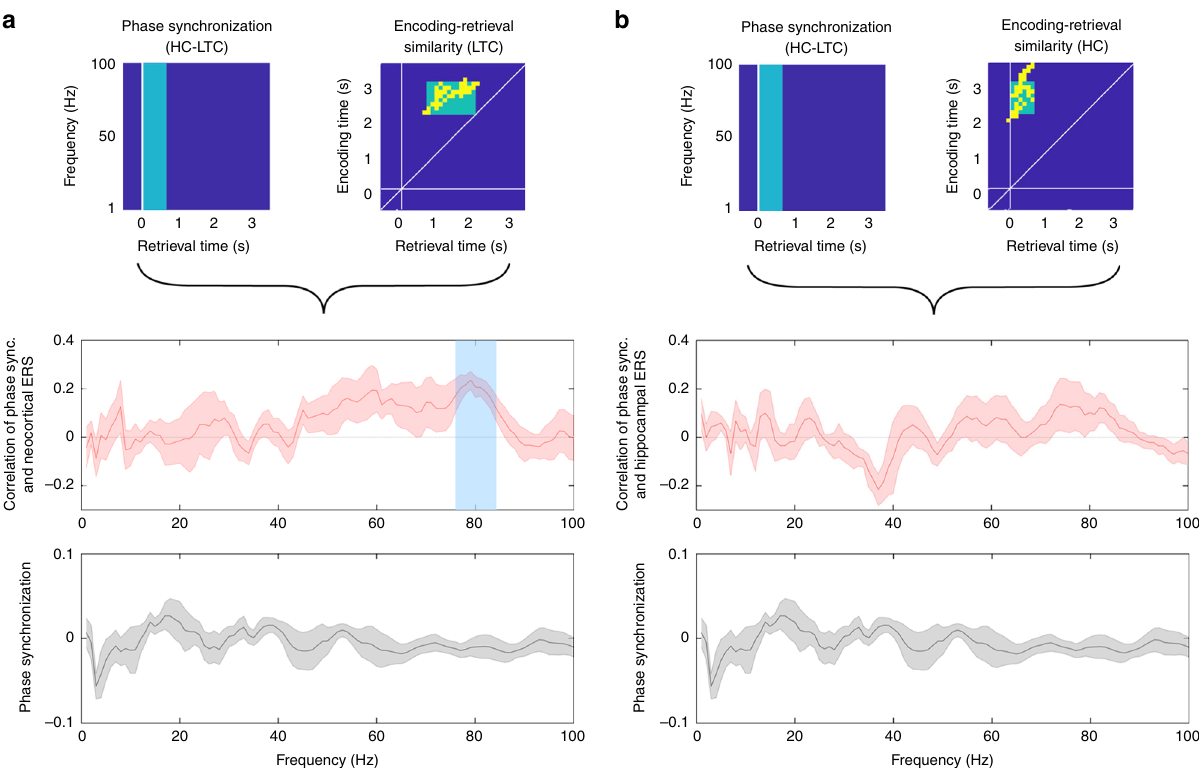
Fig. 6 Gamma phase synchronization correlates with LTC reinstatement. a Frequency-speci fi c (77 – 83 Hz) hippocampal-lateral temporal cortex phase synchronization signi fi cantly correlates with behaviorally relevant reinstatement in lateral temporal cortex (blue transparent box). b Hippocampal-lateral temporal cortex phase synchronization does not correlate with hippocampal reinstatement during the time period of increased hippocampal ERS. Curves and shaded areas in a and b show mean ± SEM of correlation of phase synchronization and LTC reinstatement (red), and mean ± SEM of